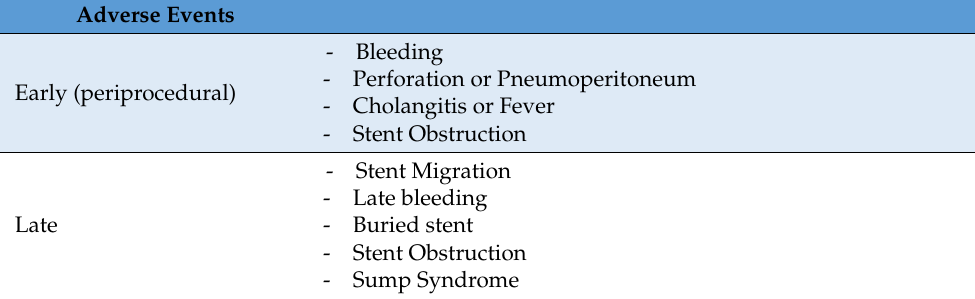
Table 2. Adverse events early (periprocedural) and